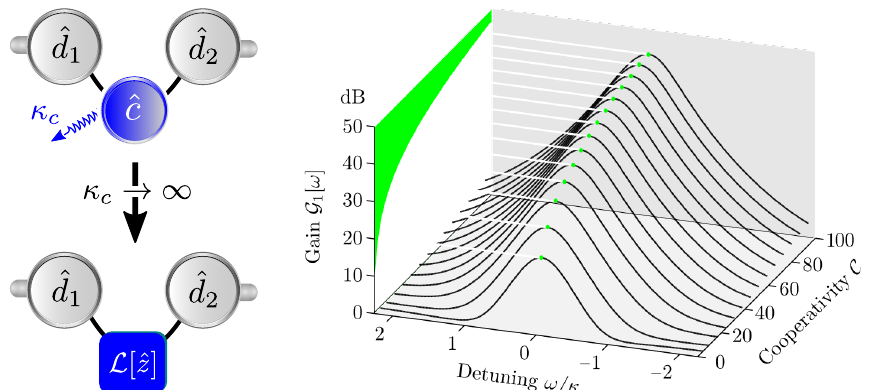
Figure 1: Dissipative amplification process between two modes d coupling to an overdamped auxiliary mode (left). The frequency dependent gain shows no reduced bandwidth when the gain is enhanced